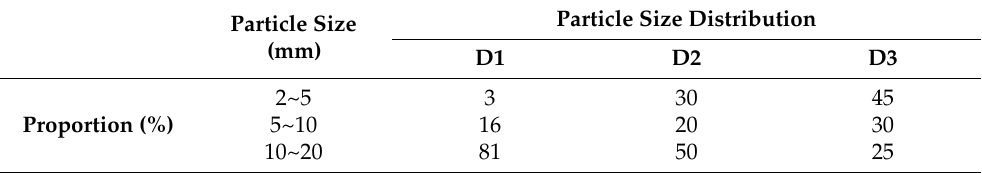
Table 2. Mixing proportion of particles. Particle